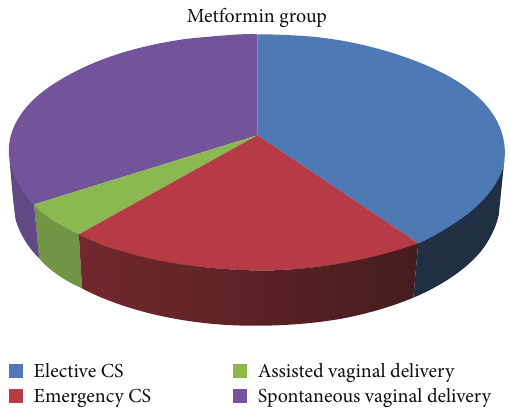
Figure 3: The figure shows % of modes of deliveries in metformin group.